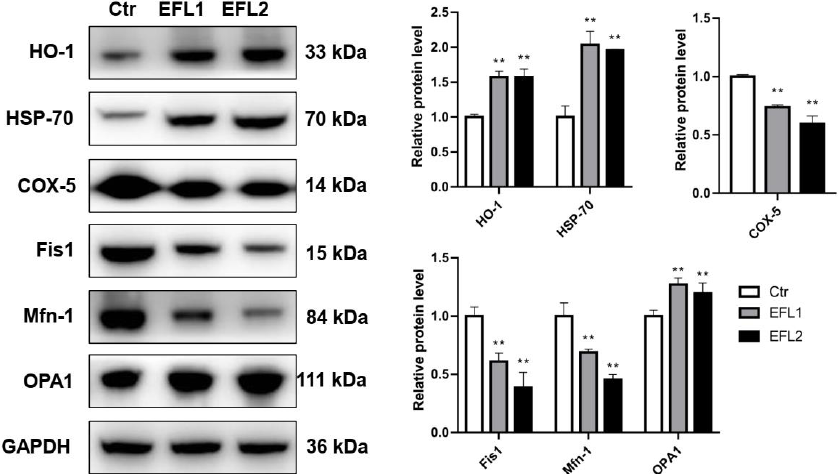
Figure 7. The relative expression levels of proteins involved in oxidative stress and mitochondrial energy metabolism. ** p < 0.01 compared with vehicle control group. energy metabolism. ** p < 0.01 compared with vehicle control